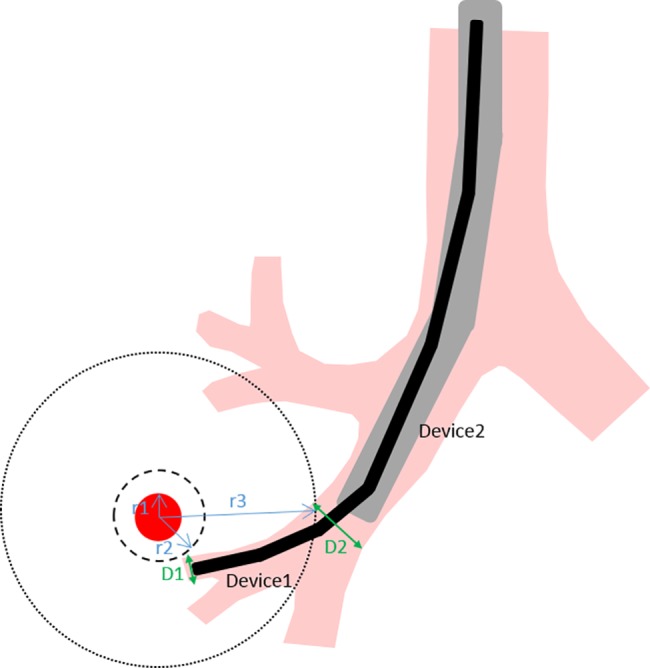
Depiction of how to calculate the off-road distance.The lesion is indicated by the red circle.